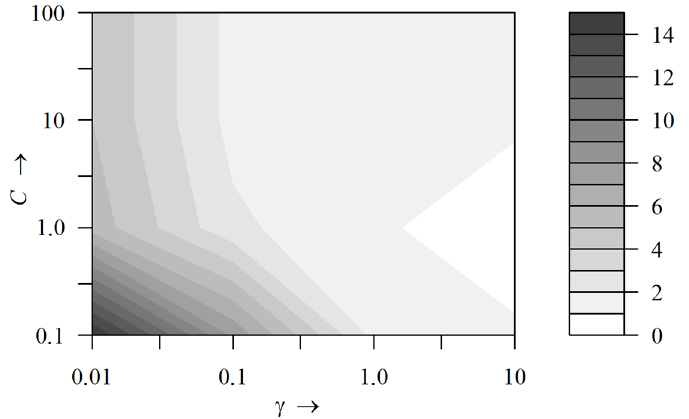
Figure 8. Grid search for the optimal parameters of the classifier SVM-1 using a cross-validation with 10 subgroups ( k = 1); error rate in p.u.